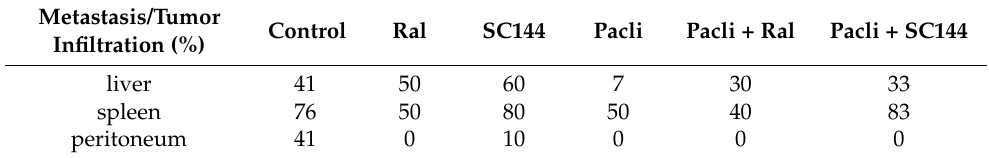
Figure 4. Combination therapy with raloxifene/paclitaxel or SC144/paclitaxel reduced tumor growth in a murine PDAC model. Mice received single or combined therapy with paclitaxel (Pacli), raloxifene (Ral) or SC144 for 26 days after orthotopic tumor cell injection. Combined treatment with raloxifen/paclitaxel (Ral + Pacli) or SC144/paclitaxel (SC144 + Pacli) reduced ( a ) weight and ( b ) volume of primary tumors compared to the control group. The data are given as mean ± SEM of n = 6–17; * p < 0.05 and ** p < 0. 01 versus control. Table 1. metastatic spread and tumor infiltration in the PDAC mouse model.